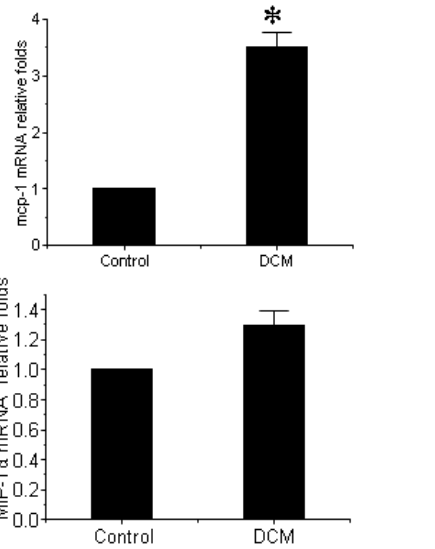
Figure 3. Monocyte Chemotactic Protein-1 (MCP-1) is a candidate myocardial homing factor of mesenchymal stem cells in dilated cardiomyopathy (DCM); ( A ) The mRNA expression level of MCP-1 is significantly up-regulated in DCM compared with control while SDF-1, MIP-1 α and MCP-3 remain unchanged. * p < 0.01 vs. control group; ( B ) MCP-1 is increased in DCM comparing to the control at the protein level. * p < 0.01 vs . control group. n = 3 per group; An independent-samples t -test was